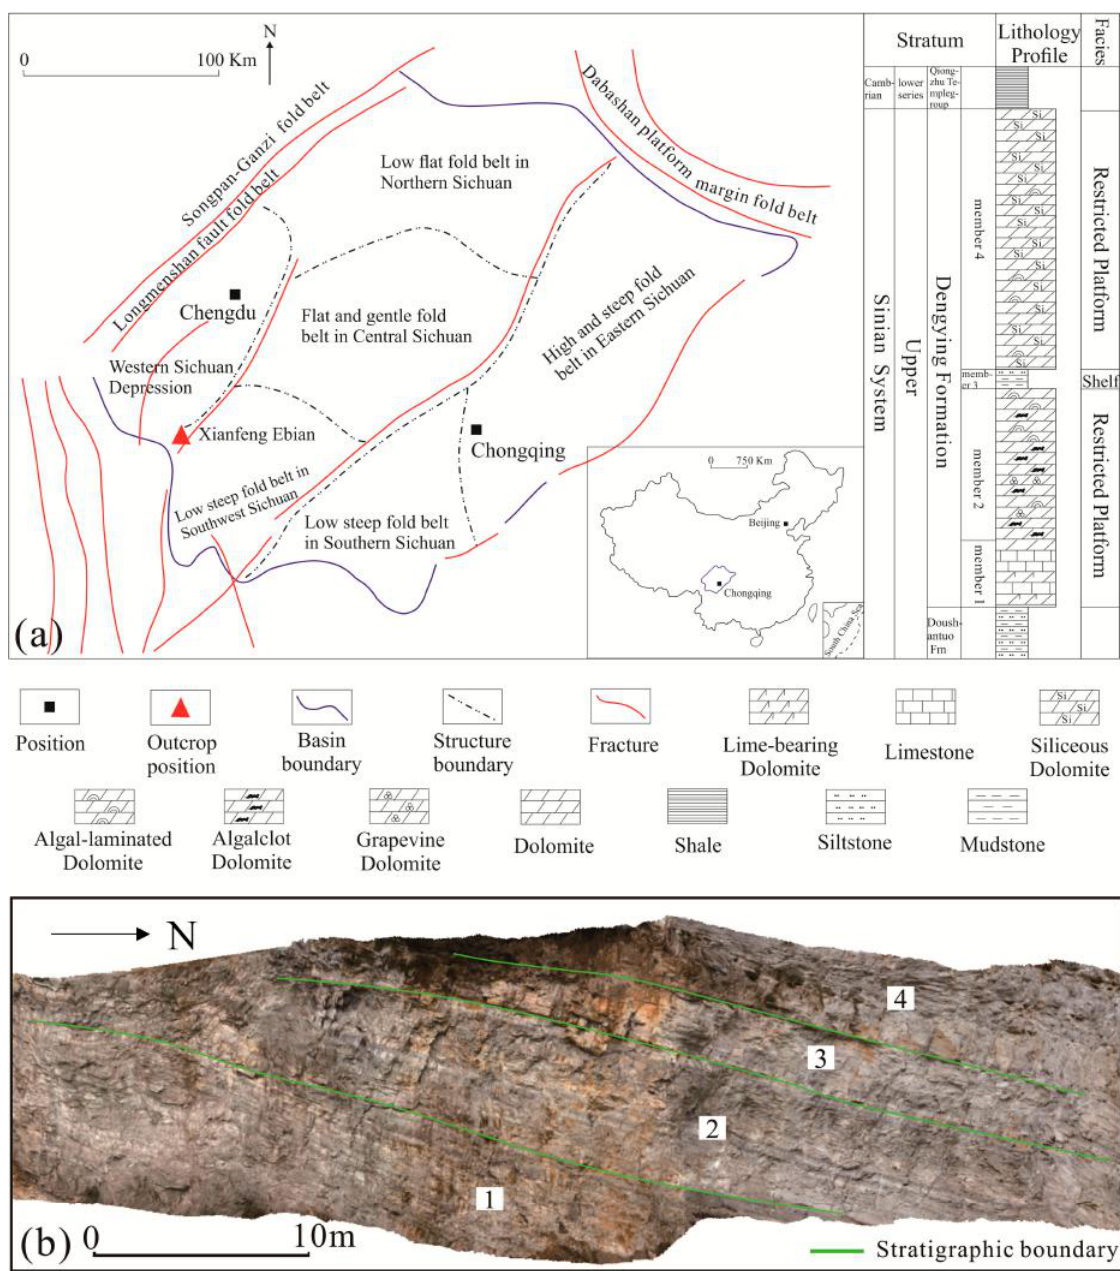
Figure 1. Geological setting. ( a ) Location map and stratigraphic histogram of the study area. ( b ) Outcrop profile for the Dengying Formation (second member).